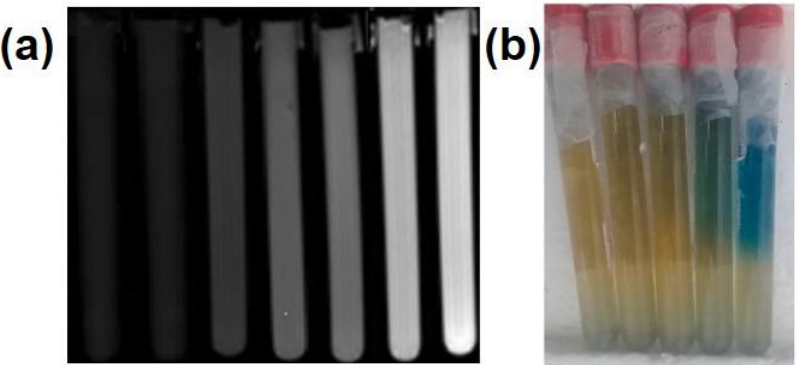
Figure 4. ( a ) MR and ( b ) digital images of dosimeters absorbed different doses. In ( a ) 0, 0.2, 1, 3, 4.5, 8 and 10 Gy and ( b ) 0.5, 1, 2, 5 and 10 Gy (from left to right), adapted from ref. [61] with permission from Elsevier.